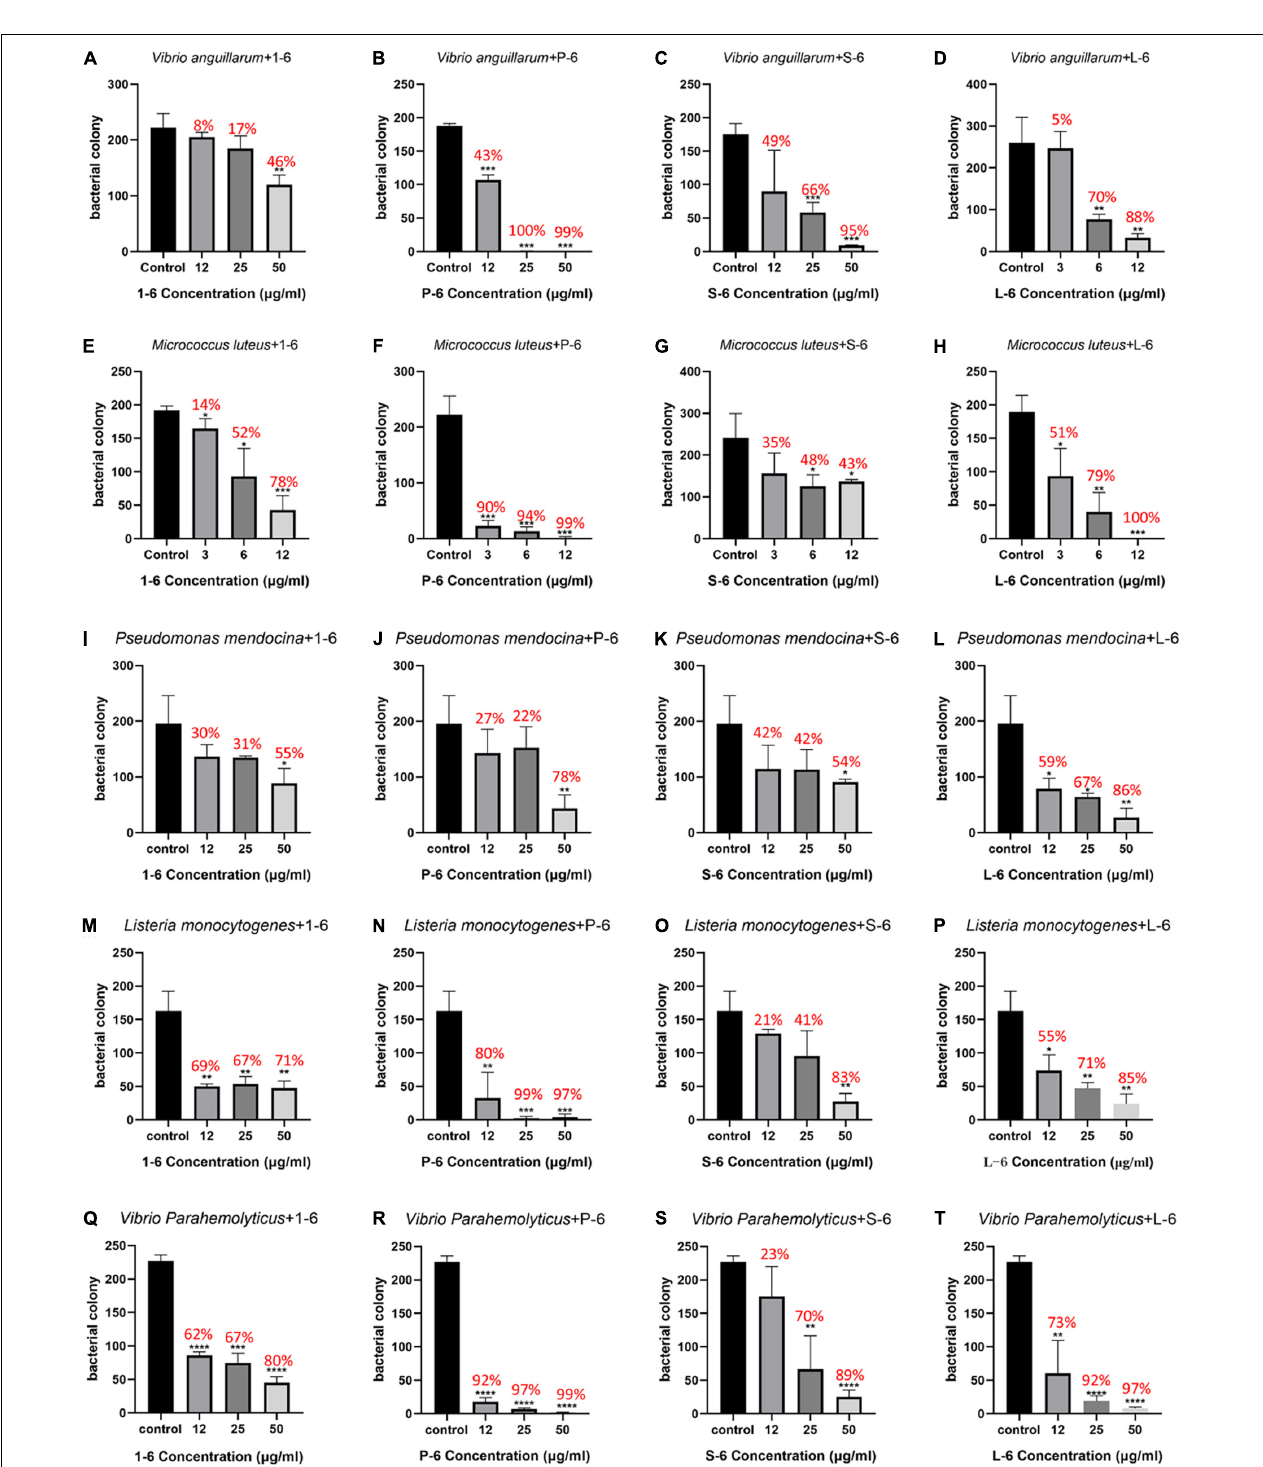
FIGURE 2 | Bactericidal activities of 1–6, P-6, S-6, and L-6 against five bacteria. (A) V. anguillarum treated with 1–6. (B) V. anguillarum treated with P-6. (C) V. anguillarum treated with S-6. (D) V. anguillarum treated with L-6. (E) M. luteus treated with 1–6. (F) M. luteus treated with P-6. (G) M. luteus treated with S-6. (H) M. luteus treated with L-6. (I) P. mendocina treated with 1–6. (J) P. mendocina treated with P-6. (K) P. mendocina treated with S-6. (L) P. mendocina treated with L-6. (M) L. monocytogenes treated with 1–6. (N) L. monocytogenes treated with P-6. (O) L. monocytogenes treated with S-6. (P) L. monocytogenes treated with L-6. (Q) V. parahaemolyticus treated with 1–6. (R) V. parahaemolyticus treated with P-6. (S) V. parahaemolyticus treated with S-6. (T) V. parahaemolyticus treated with L-6. All data are expressed as means ± SD. The t -test was used to evaluate significant differences between controls and treatment groups. * p < 0.05, ** p < 0.01, *** p < 0.001, and **** p <